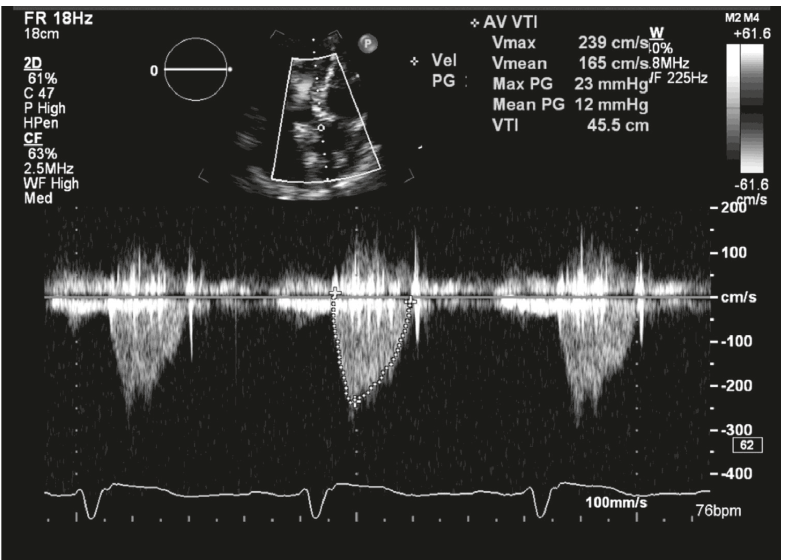
Figure 3: Transaortic Doppler at 30 days after TAVI reveals mean systolic gradient of 12 mmHg and no aortic insufficiency. TAVI � transcatheter aortic valve